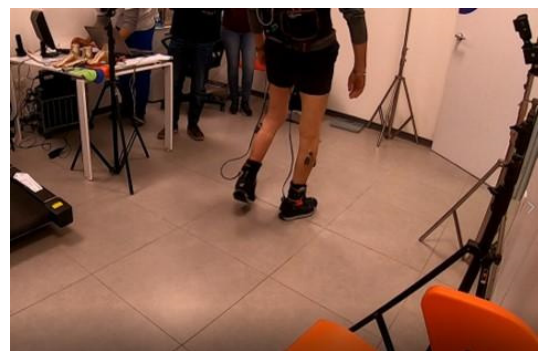
Figure 1. Example of acquisition set up.